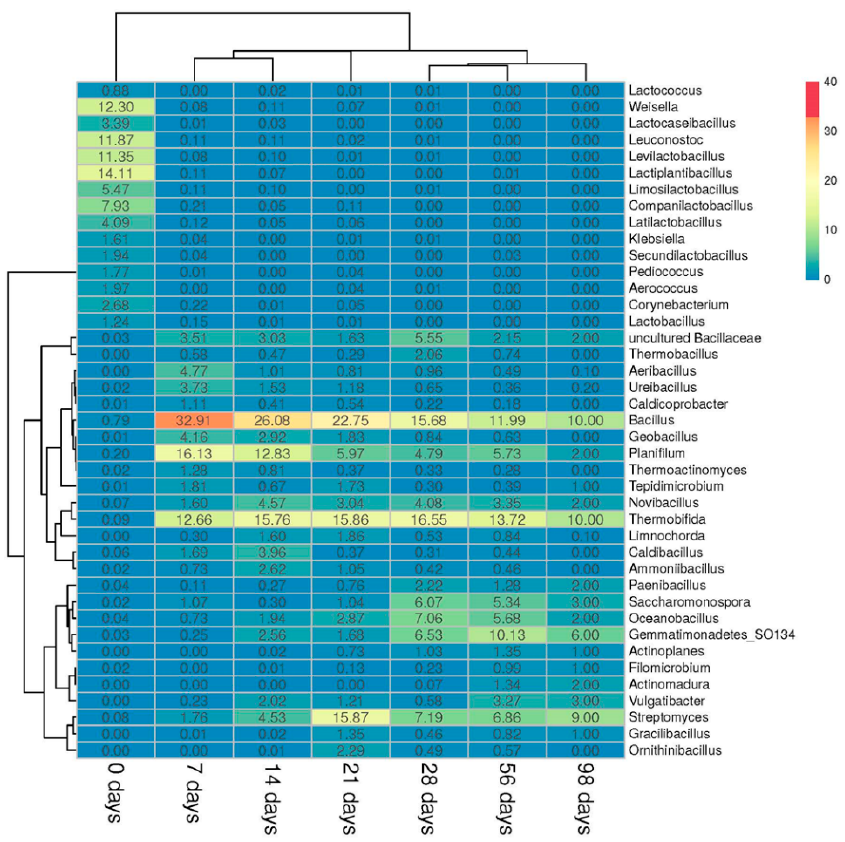
Figure 4. The heat map of the distribution of the most relatively abundant (>1%) prokaryotic genera on days 0, 7, 14, 21, 28, 56, and 98 of composting. The genus abundance was calculated by dividing the sequence proportions by the total sequence count in the sample. The relative abundance of the genus is shown by color.